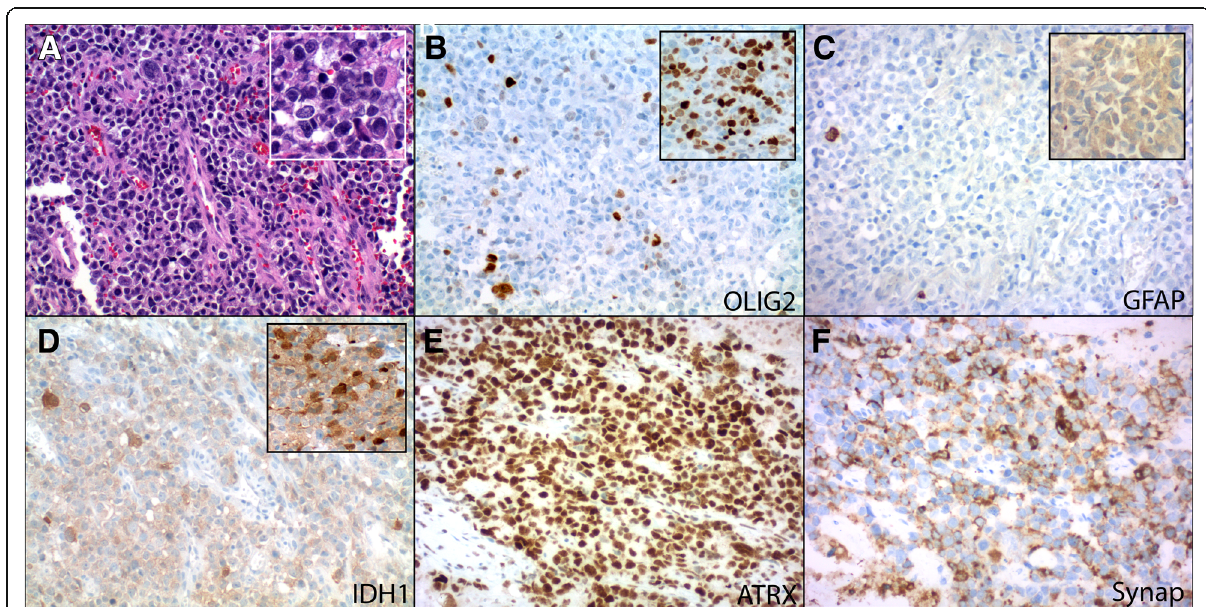
Fig. 2 Routine hematoxylin and eosin stains (H&E) showed infiltrative sheets of discohesive neoplastic cells ( a , 200X; inset, 400X). The majority of cells demonstrated high nuclear to cytoplasmic ratios with round hyperchromatic nuclei and moderate nuclear pleomorphism. A subset of cells showed gemistocytic morphology with eccentrically displaced dense eosinophilic cytoplasm ( a , 200X; inset, 400X). Occasional giant cells were also noted. Ancillary immunohistochemical stains showed that the neoplasm contained some areas of IDH1-mutant protein positive cells and other areas that were predominantly IDH1-mutant protein negative to weakly positive ( d , 200X; inset, 200X). GFAP ( c , 200X; inset, 200X) and OLIG2 ( b , 200X; inset, 200X) expression was also variable. ATRX protein expression was uniformly retained throughout ( e , 200X) and synaptophysin was diffusely positive ( f , 200X). The neoplasm also co-expressed NeuN and S-100 protein, while chromogranin was focal (not shown). INI-1 and BRG1 were retained. Additional stains for CD99, HH3 K27M, SOX10, CD30, myogenin, desmin, CAM5.2 (CK8/18), AE1/AE3, OCT3/4, Melan A, CD45, CD3, and CD20 were negative in the